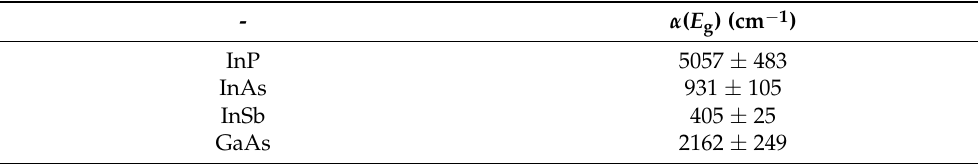
Table 3. α ( E g ) calculated with Equation (7) using the fit parameters in Table